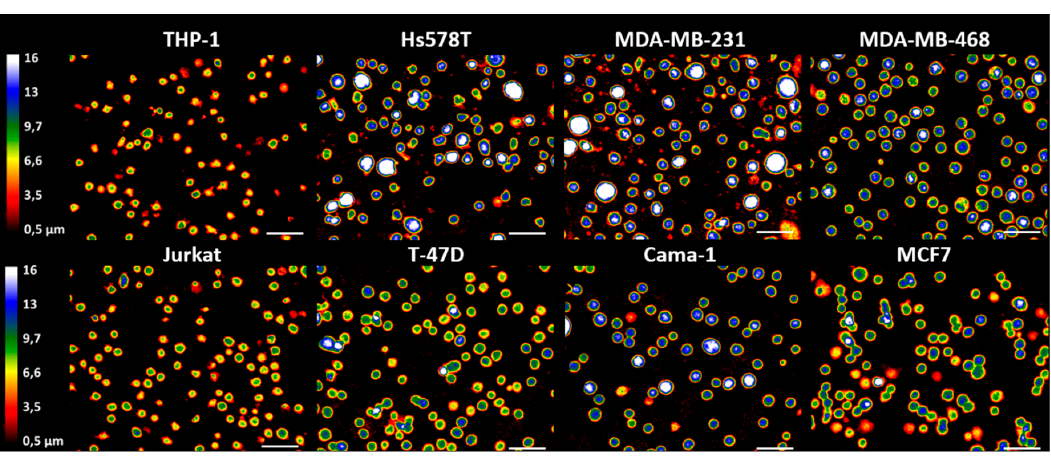
The two WBC lines THP-1 and Jurkat, and the six different breast cancer cell lines were analyzed for cell mean volume, mean area and mean thickness with DHC (Figures 2 and 3). As shown here, the WBC cell lines THP-1 and Jurkat were consistently smaller than the six breast cancer cell lines.